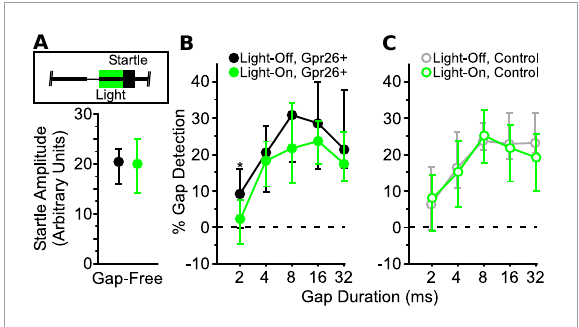
FIGURE3 Suppression of Gpr26 neurons reduces behavioral gap detection. Light (520 nm, 300 mW/mm 2 ) was delivered to auditory cortex through chronically-implanted optic fibers during the 50 ms interval preceding the startle (inset in A ). Behavioral data were collected from Gpr26 ( n = 5, 19 sessions) and control ( n = 4, 12 sessions) mice. (A) No difference in pure startle amplitude (gap-free trials) was observed with illumination for Gpr26 mice ( p = 0.87, η 2 = 0.001). To compare gap detection across durations, we normalized startles to the median non-illuminated gap-free startle. (B,C) Illumination significantly reduced gap detection in Gpr26 mice, but had no impact on controls. Boxes show median and IQR. * p < 0.05, rank-sum post hoc